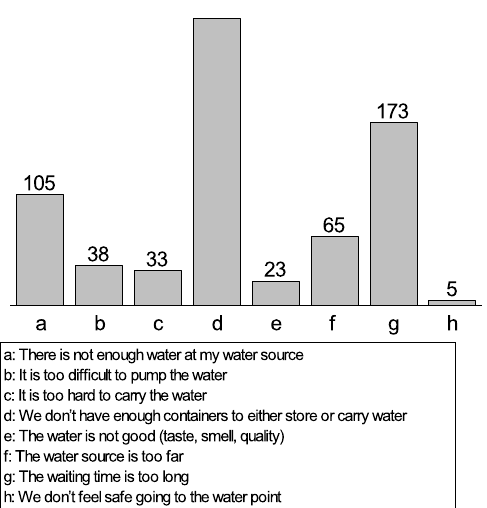
Figure 2. Answers to the question “Why don’t you have enough water?” from the conducted survey (Supplementary Material A.13). People could choose more than one